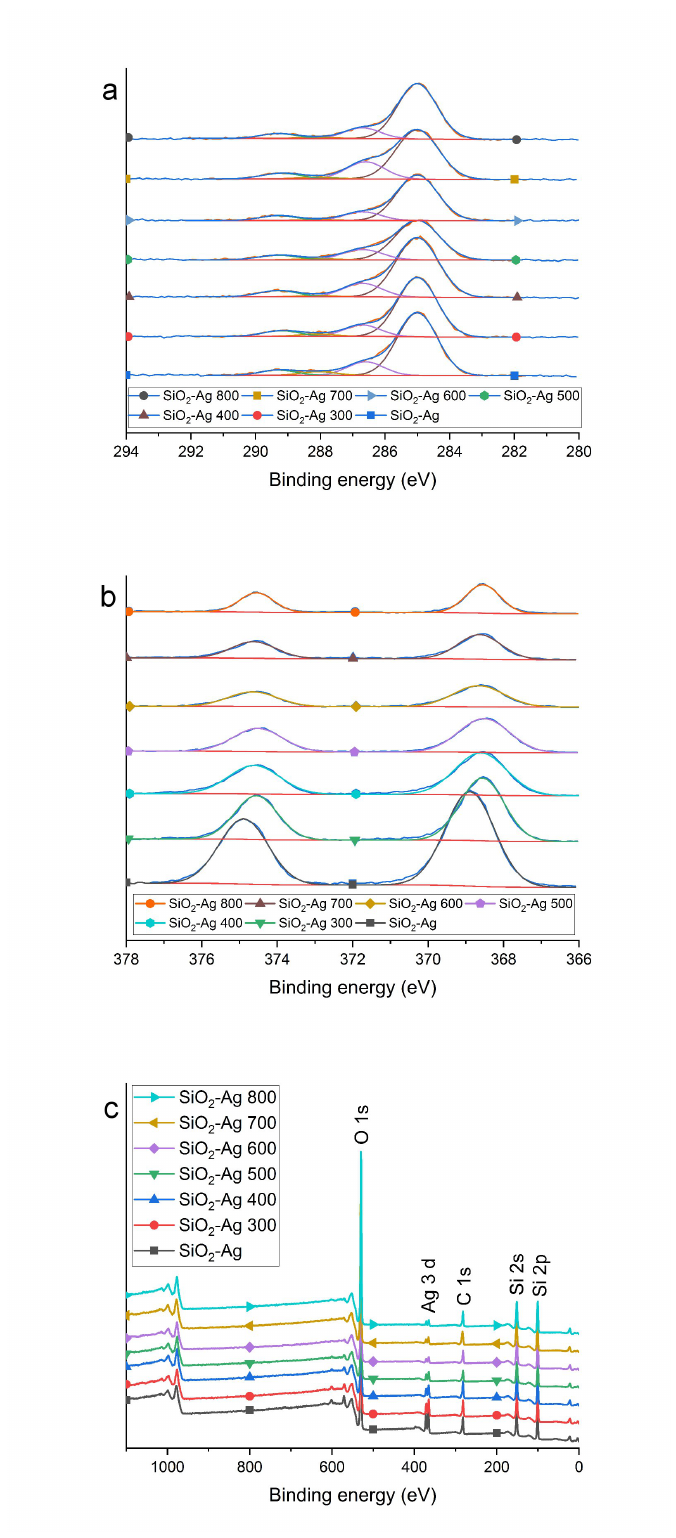
Figure 5. High resolution XPS spectra showing ( a ) the C 1 s high resolution spectra and ( b ) the Ag 3d peaks for the powders. XPS survey spectra of ( c ) all SiO 2 -Ag powders. The interaction between the Ag NPs and the SiO 2 matrix and functional groups in the composite samples were investigated by Fourier Transform Infrared spectroscopy (FTIR), as observed in Figure